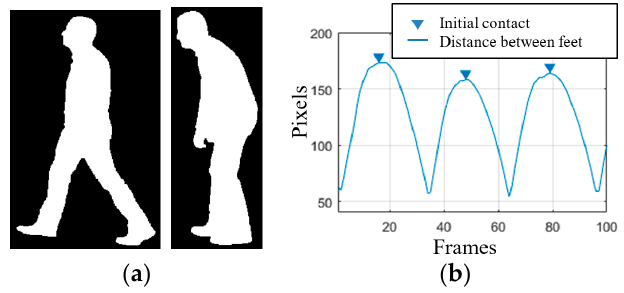
Figure 2. ( a ) Silhouettes belonging to a healthy individual (left) and an individual suffering from a systemic disorder (right); ( b ) plot representing the distance between feet along a gait sequence.